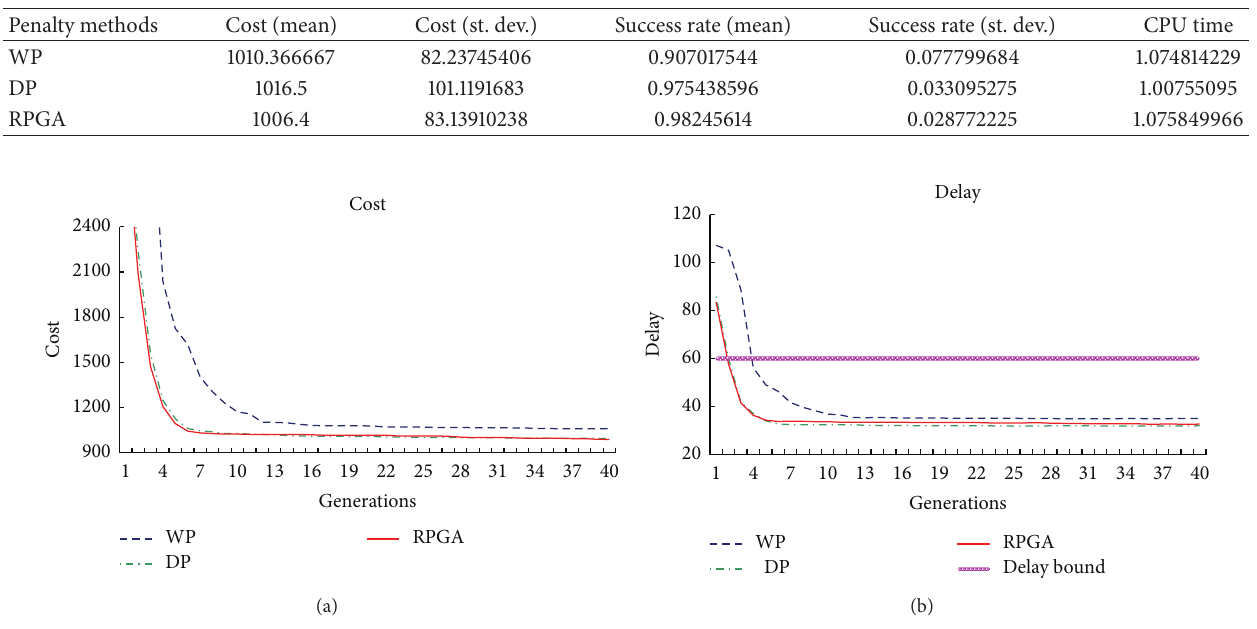
Figure 9: Evolution curves of three methods on the performance metrics: (a) cost and (b) delay.